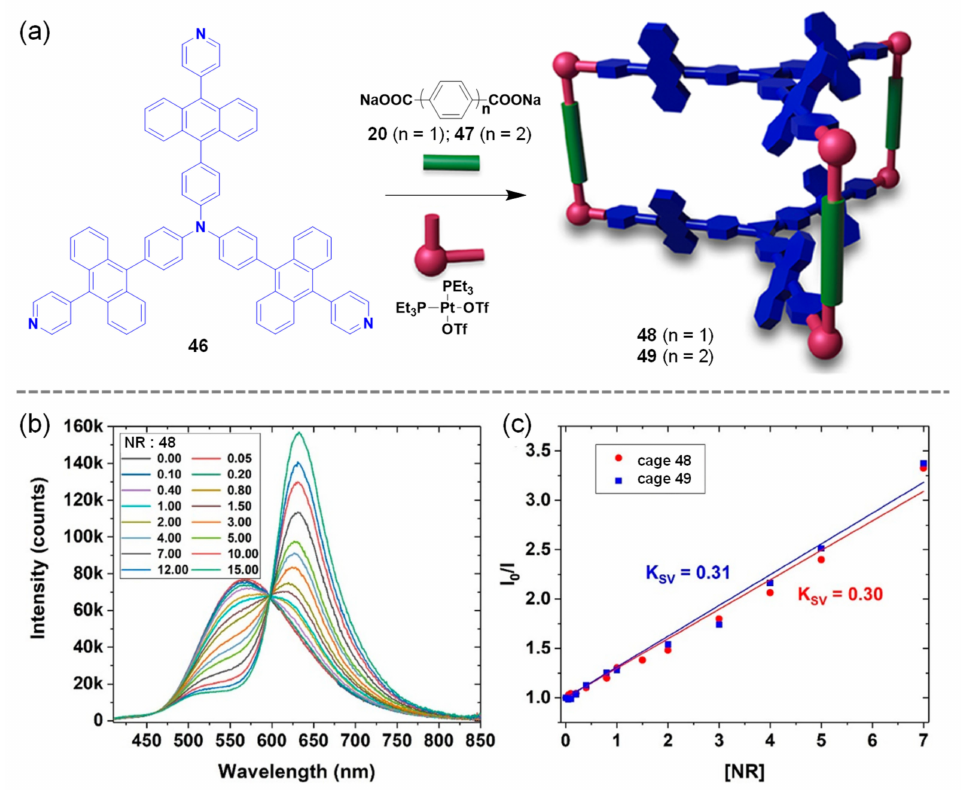
Figure 11. Trianthracene − triphenylamine-based platinum(II) metallacages 48 and 49 for light har- vesting energy transfer. ( a ) Schematic representation of the syntheses of metallacages. ( b ) Emissive titration of 48 with varying amounts of Nile Red (NR). ( c ) The corresponding Stern − Volmer analyses of 48 and 49 in the presence of different concentration ratios of NR. Reprinted with permission from Ref. [96]. Copyright 2021 American Chemical